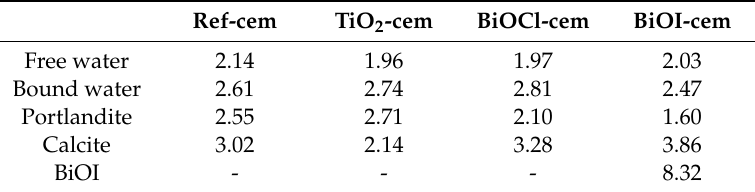
Figure 7. TGA results of reference cement-based sample and photocatalyst/cement composites. Table 2. Weight loss (%) of compounds obtained by TGA in mortar samples.